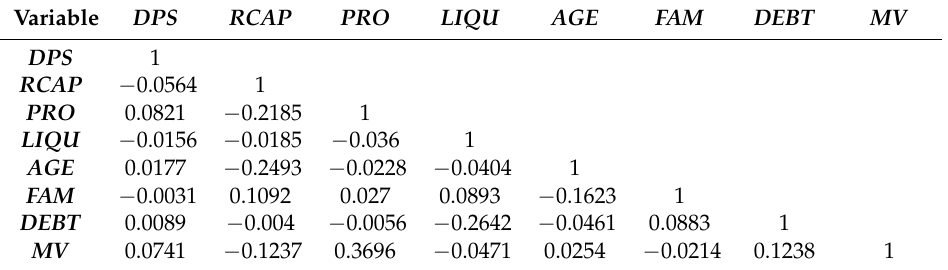
Table 3. Correlation Matrix between